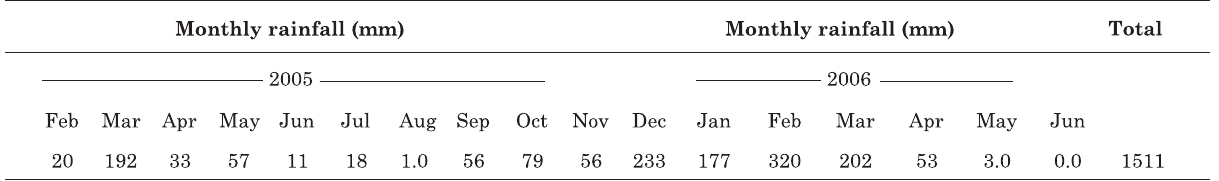
Table 2. Monthly rainfall measured in the experimental area during the crop growth